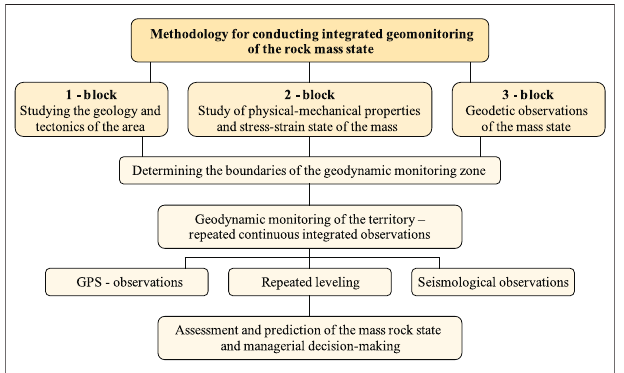
FIGURE 1 | Scheme of an integrated methodology for conducting